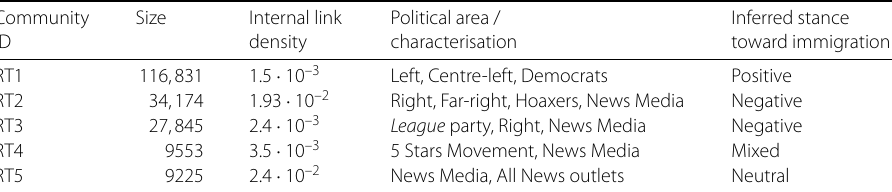
Table 1 The communities found in G in terms of size, internal link density, political leaning and/or general characterisation, and inferred stance toward immigration